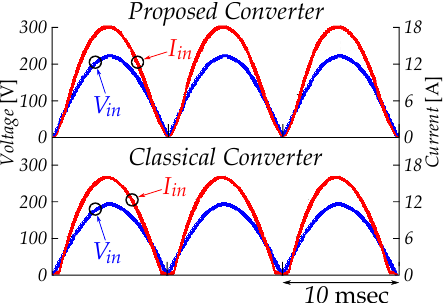
Figure 8. Comparison under the condition of maximum power and minimum output voltage.